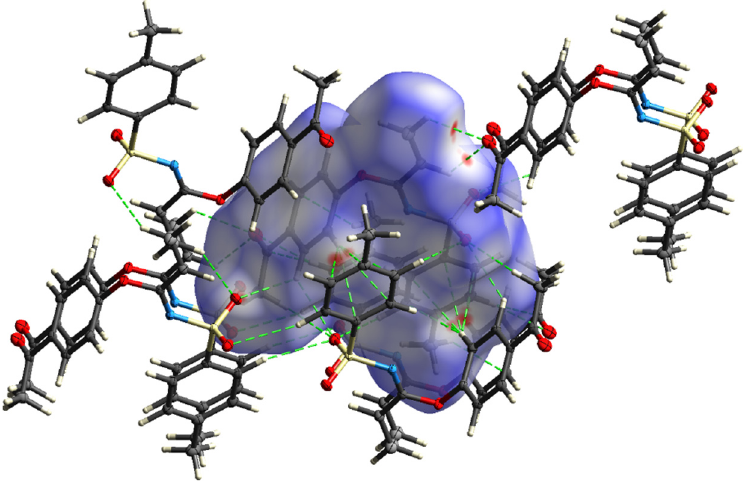
Figure 7. Hirshfeld surface of 3 mapped with d norm , showing potential hydrogen bond (dashed lines).